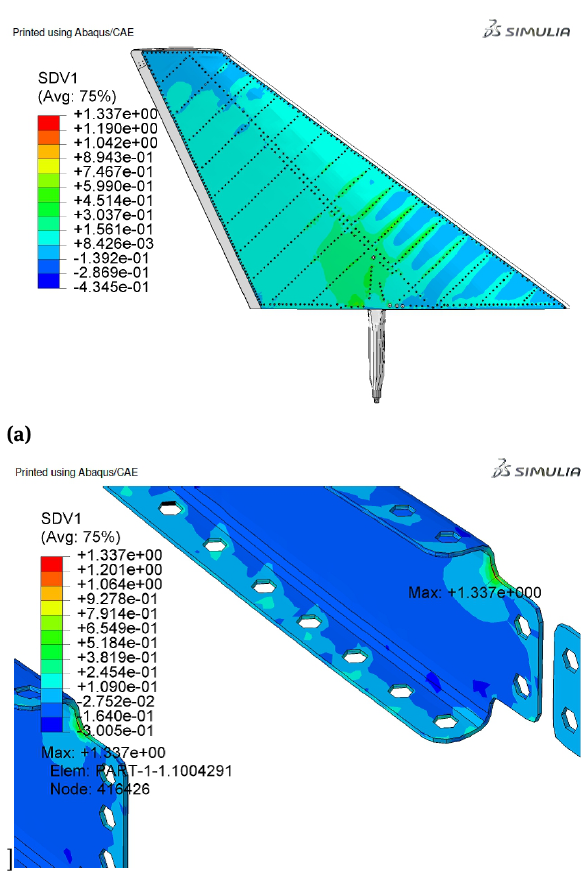
Figure 6: (a) FI Plot for assembly (b) Maximum value of FI at a rib